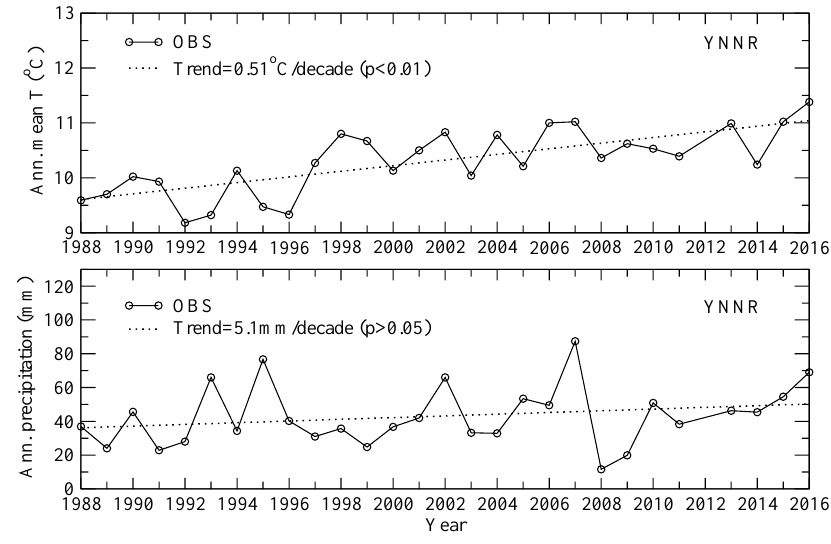
Figure 13. The time series plots and trends of the annual mean temperature ( top ) and annual precipitation ( bottom ) in the YNNR.